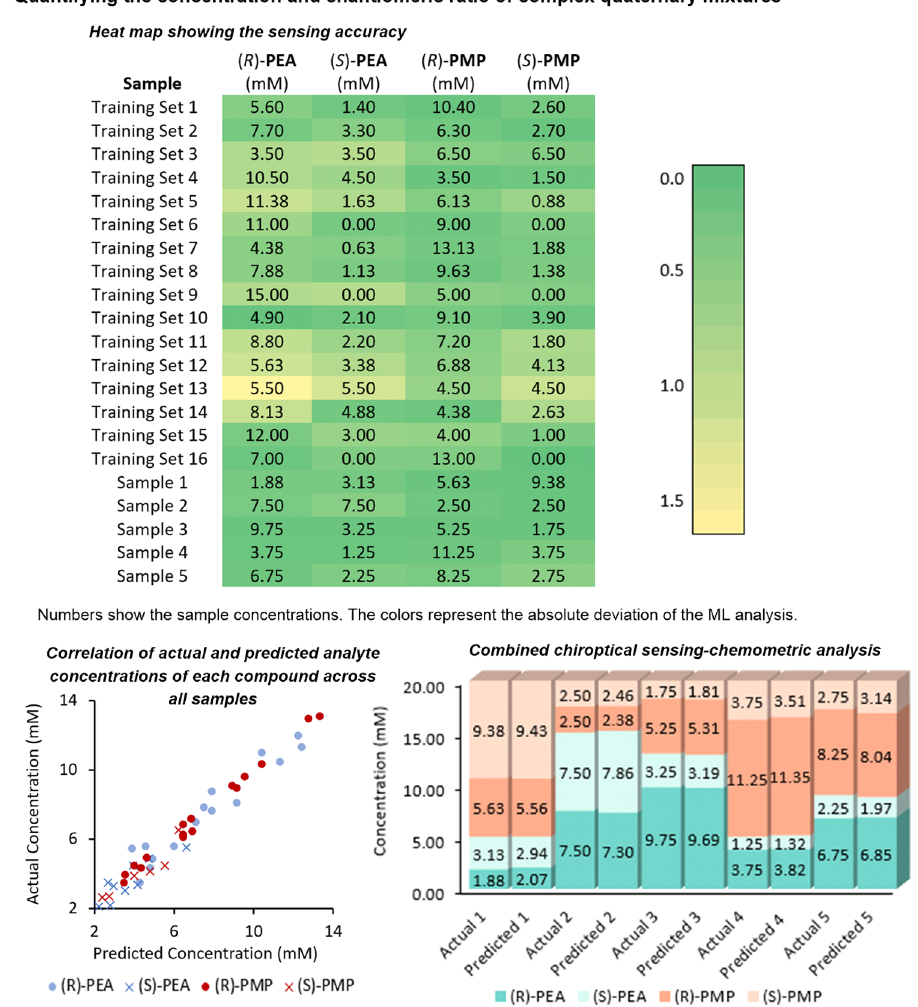
Fig. 4 Chiroptical sensing of quaternary mixtures. Heat map for the 16 training sets and the 5 samples. Color corresponds to the absolute error of predicted [mM] versus actual [mM]. The sensing-chemometrics analysis results are compared to the actual data in the stacked column chart. PEA : 1-phenylethylamine, PMP : 1-(pyrrolidin-2-ylmethyl)pyrrolidine. The data underlying this fi gure are available as Source